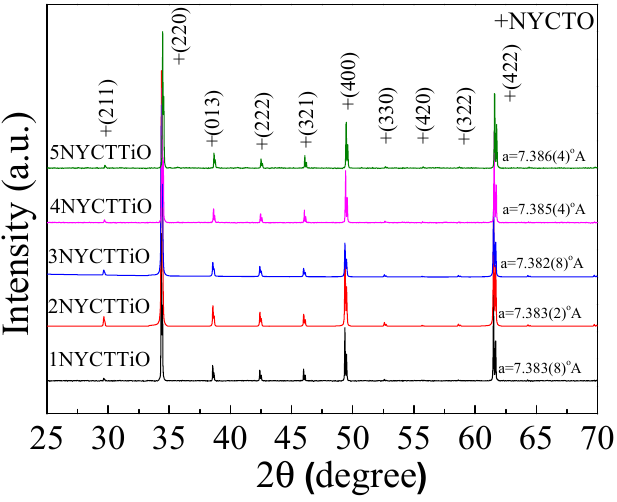
Figure 1. XRD patterns of the Na 1/2 Y 1/2 Cu 3 Ti 4.1 O 12 ceramics sintered at 1070 °C for 1, 5, and 15 h and sintered at 1080 and 1090 °C for 5 h. Figure 2a–e show the morphologies of Na 1/2 Y 1/2 Cu 3 Ti 4.1 O 12 ceramics sintered under